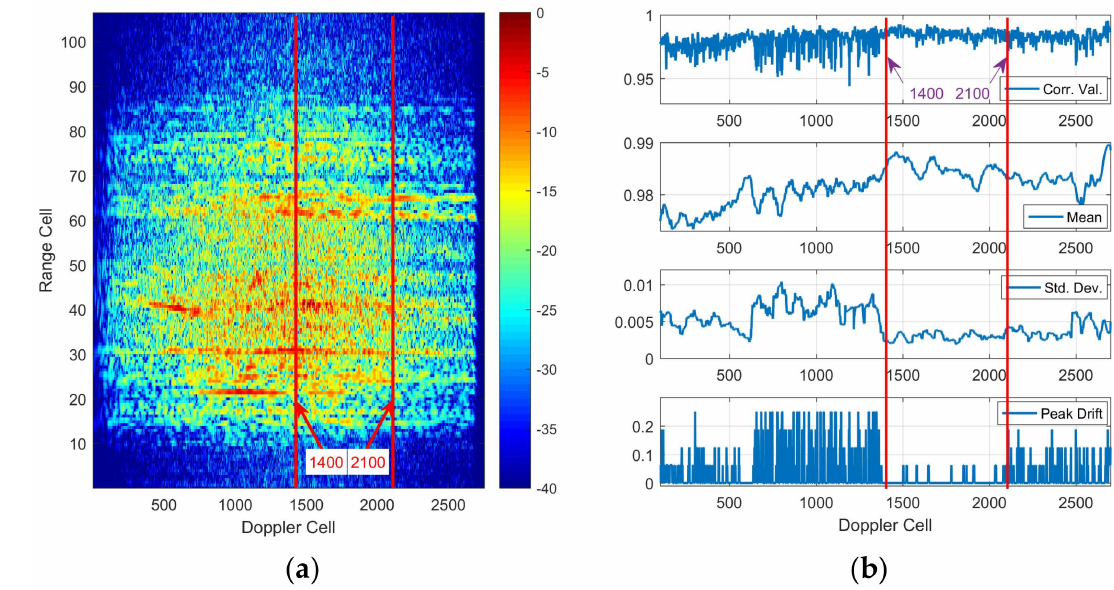
Figure 9. Correlation characteristics of experimental test. ( a ) Data in range-Doppler domain; and ( b ) four correlation characteristics.